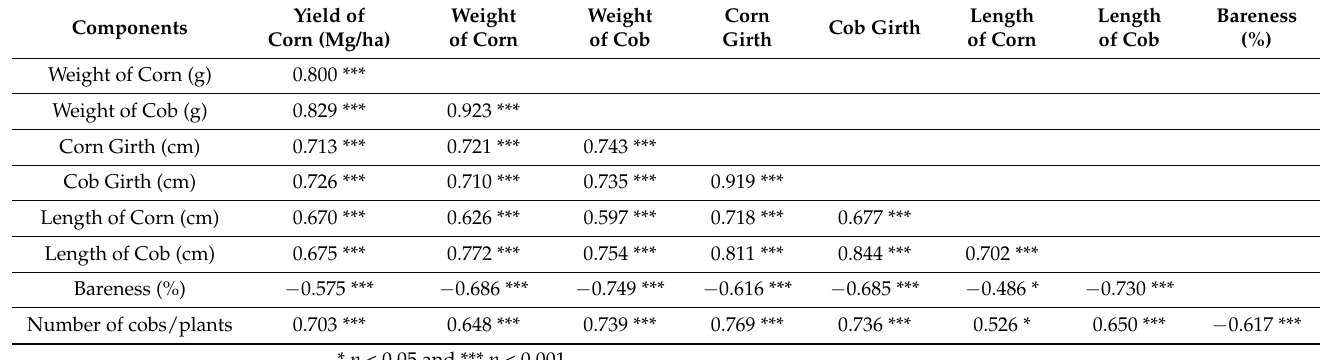
Table 7. Correlations between corn yield and yield attributes of baby corn.